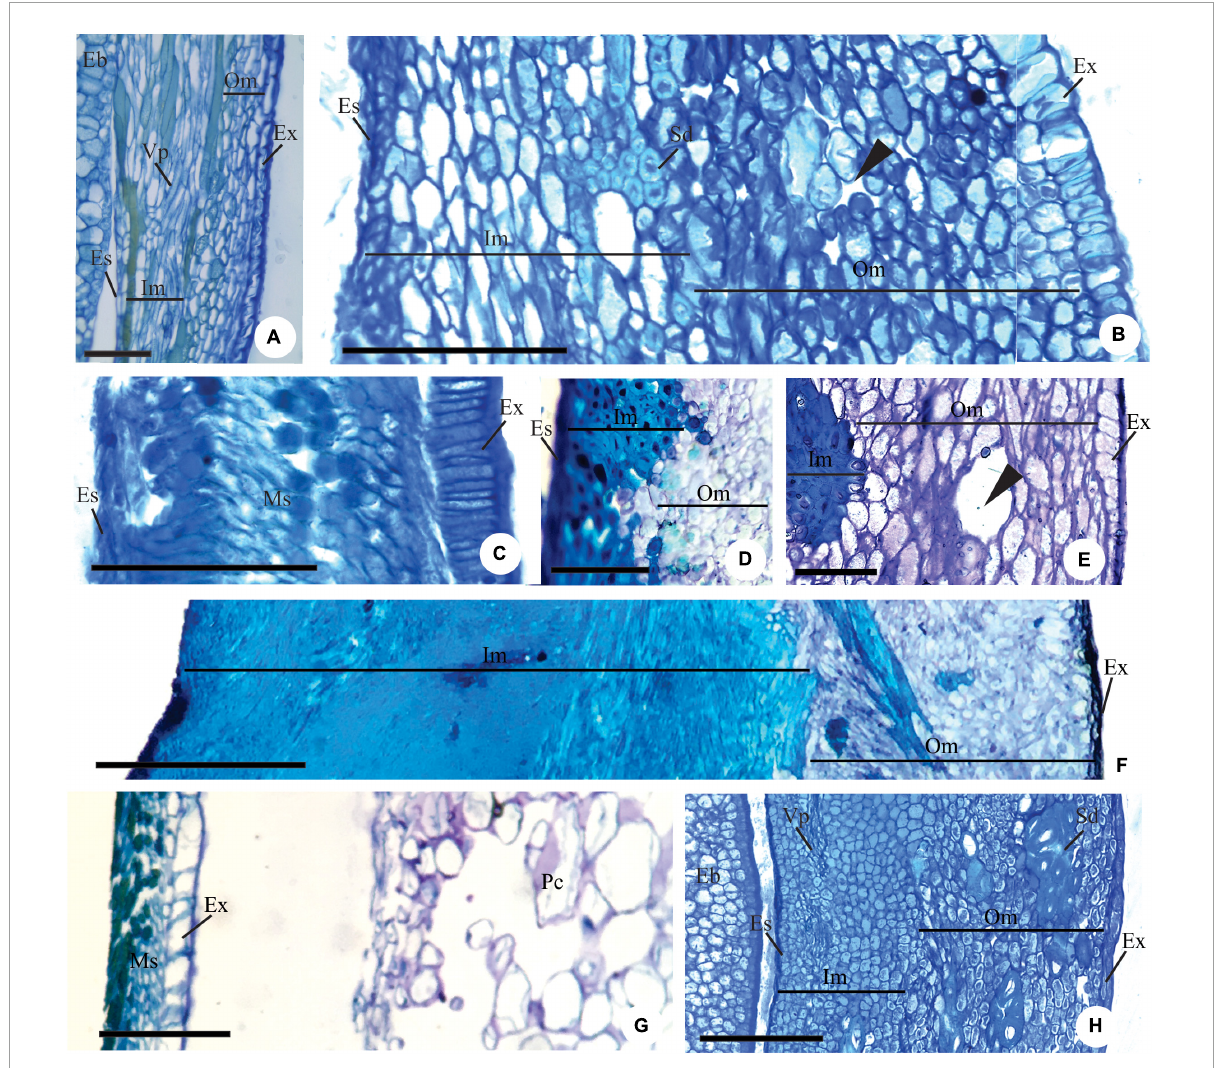
FIGURE4 Details of longitudinal sections showing the pachychalazal (A,B,D–F,H) and testal (C,G) seed-coat in the immature (A–C) and mature seed (D–H) Eugenia subterminalis (A) , E. modesta (B) , E. goiapabana (C) , E. arenosa (D,E) , E. myrcianthes (F) , E. brasiliensis (G) , and E. acutata (H) .